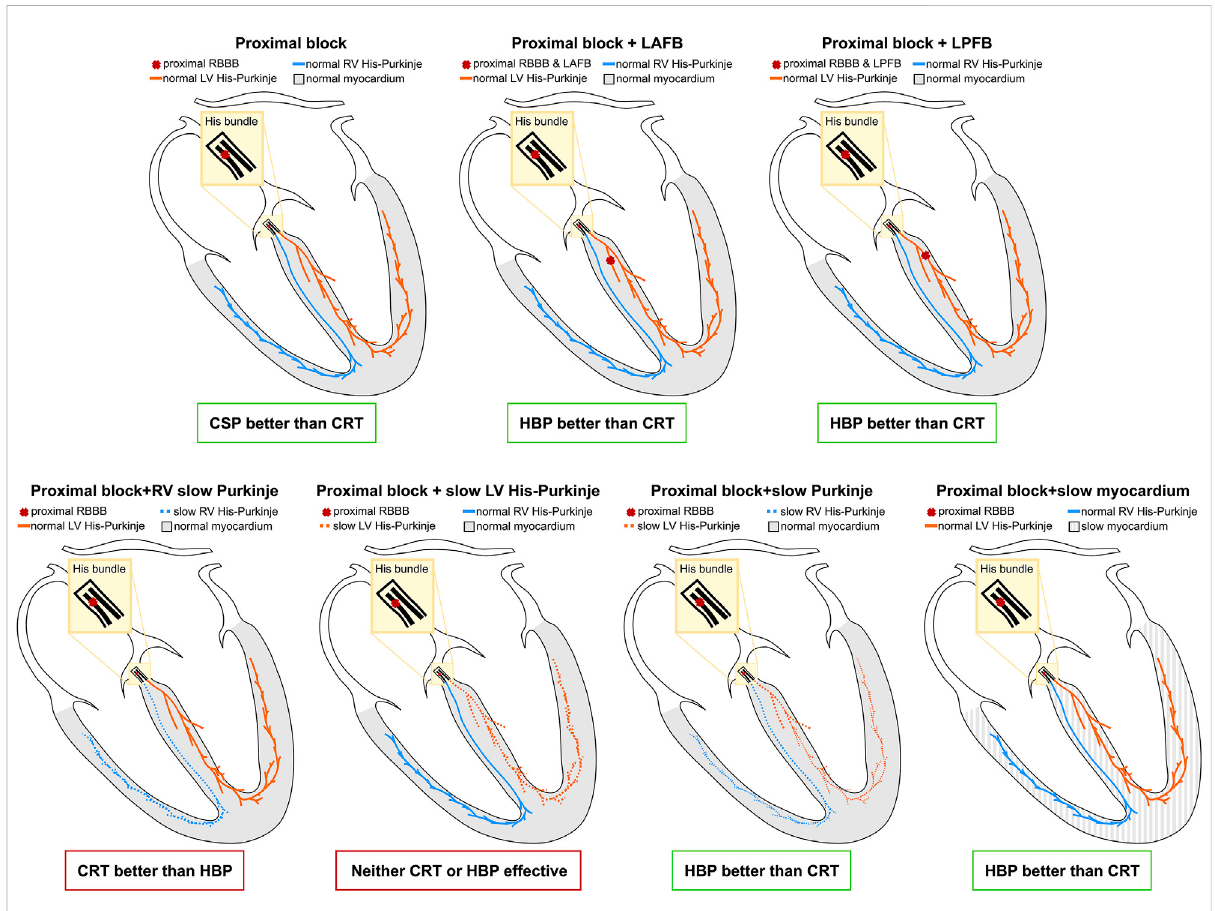
FIGURE 9 Results summary: The yellow area represents the His bundle, with a proximal block (red cross) introduced along the strands going to the right bundle. Additional blocks were introduced in the left anterior and posterior fascicles. The LV and the RV Purkinje system are represented in orange and the blue, and the ventricular myocardium is depicted in